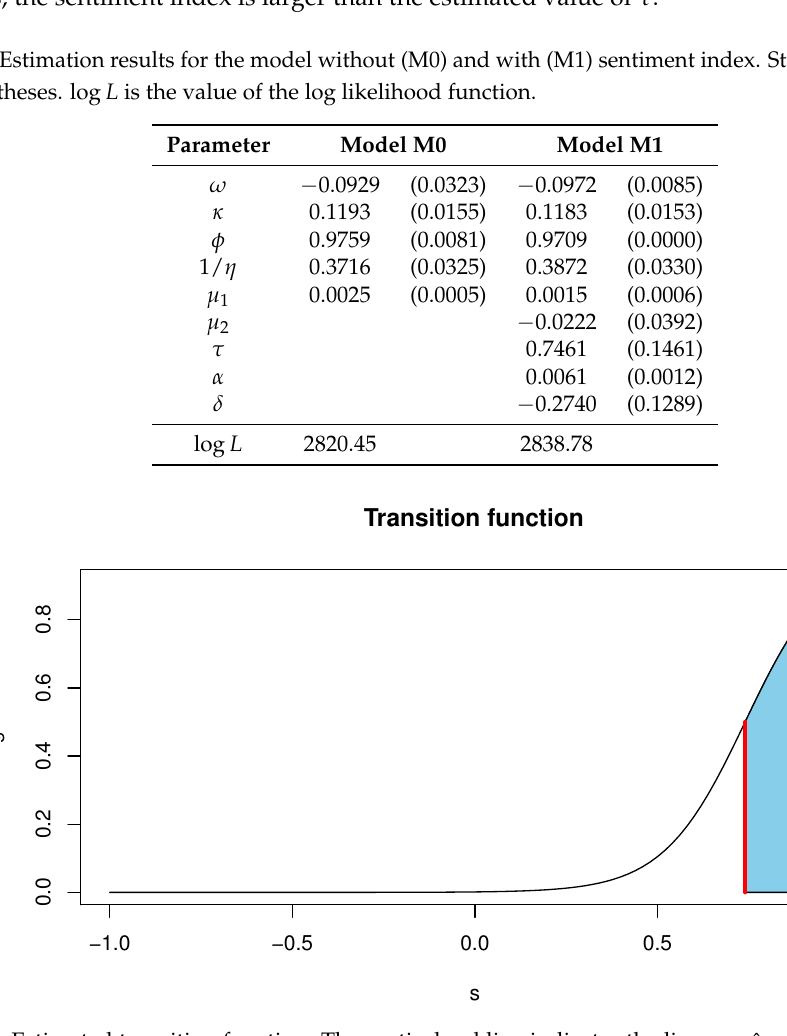
Figure 3. Estimated transition function. The vertical red line indicates the line s = ˆ τ = 0.746, for which g ( s t ) = 1/2. Values above this line, i.e., the shaded area, are interpreted as the bubble